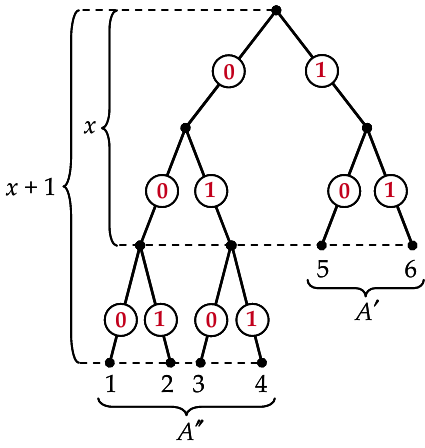
Figure 2. Code tree for n = 2 and | A | =